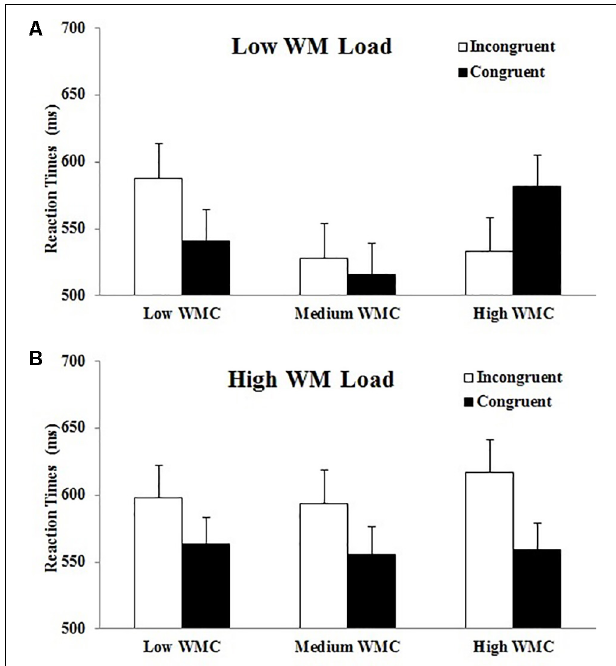
FIGURE 4 | Mean reaction times (and standard error of the mean) for congruent and incongruent prime-target pairs as a function of WM load ( A : low load; B : high load) and WMC group (low-, medium-, and high-WMC) in Experiment 1.